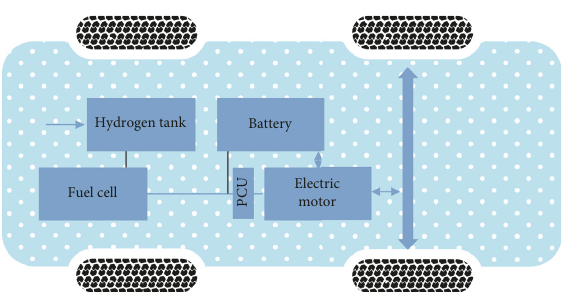
Figure 4: HFCEV car representation.